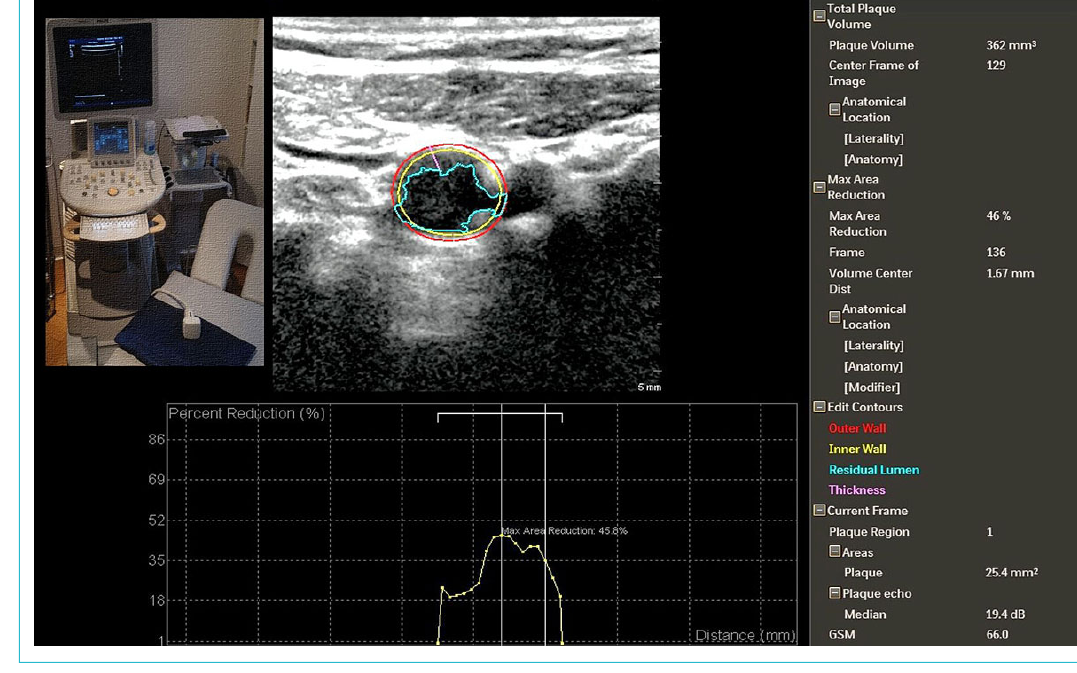
Figure 5: Semiautomatic measurements of transversal plaque areas obtained from a Philips iU 22 ultrasound system equipped with the single sweep volumetric transducer vL 13-5. Analysis was performed offline with software provided by the manufacturer. The software calculates the total plaque volume from all transversal carotid plaque areas obtained by the single sweep volumetric transducer over a field of view of 3.8